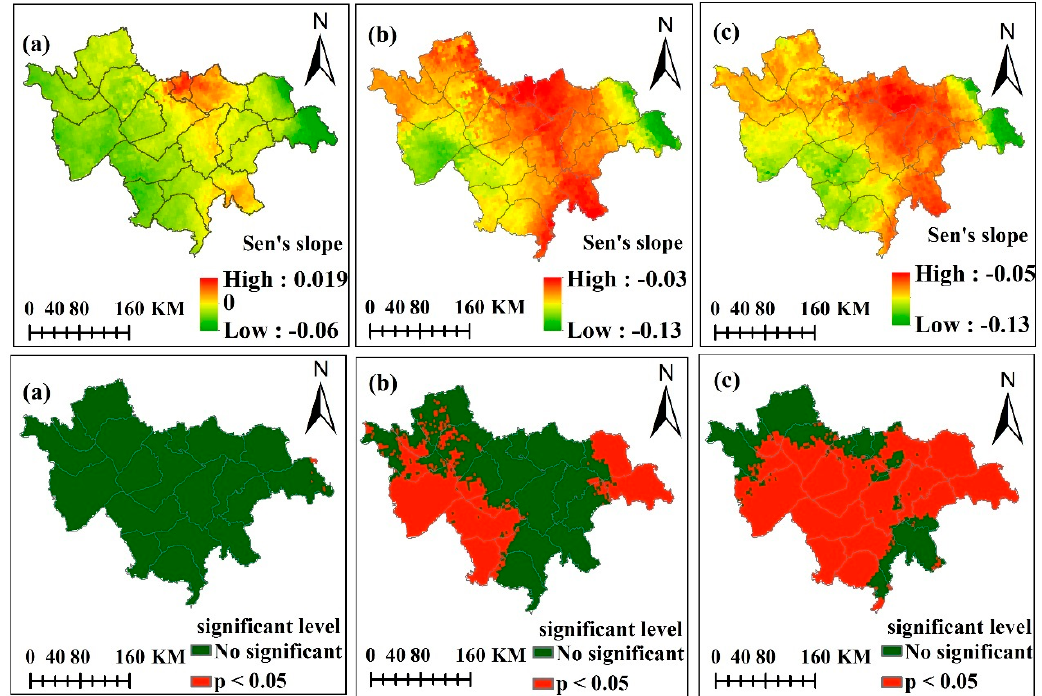
Figure 6. Spatial pattern of Sen’s slope of the CDWI from 1982 to 2015 at different stages in Midwestern Jilin Province. ( a – c ) Represent the stages of emergence-tasseling stage, tasseling-milky maturity, and milky maturity-mature, respectively.